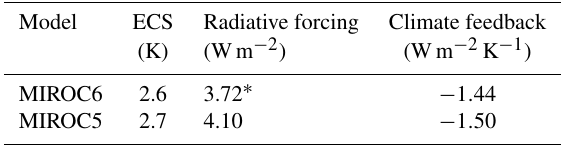
Table 2. Effective climate sensitivity (ECS), radiative forcing of CO 2 doubling, and climate feedback for MIROC6 and MIROC5. The MIROC6 result marked with an asterisk ( ∗ ) is different from MIROC5 at the 5%